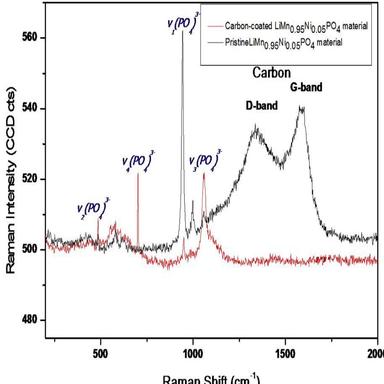
Raman spectra for LiMn0·95Ni0·05PO4 before and after carbon coating.